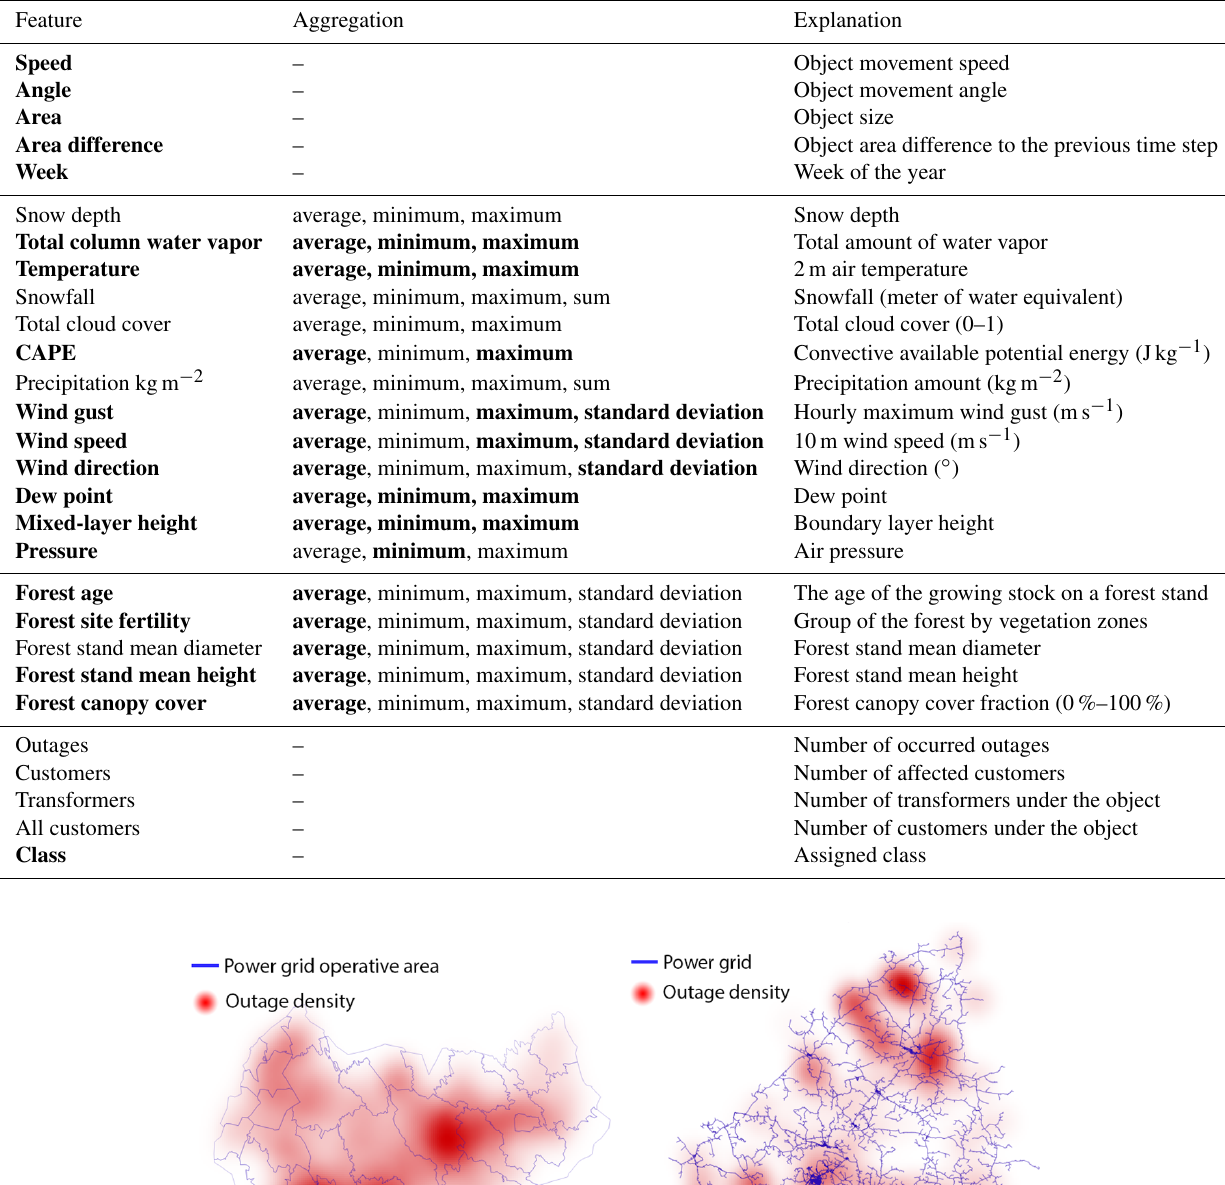
Table 1. Extracted features. Features used in the final classification are marked as bold.